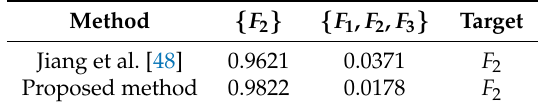
Table 11. Fusion results by using different combination methods at 2 X frequency.